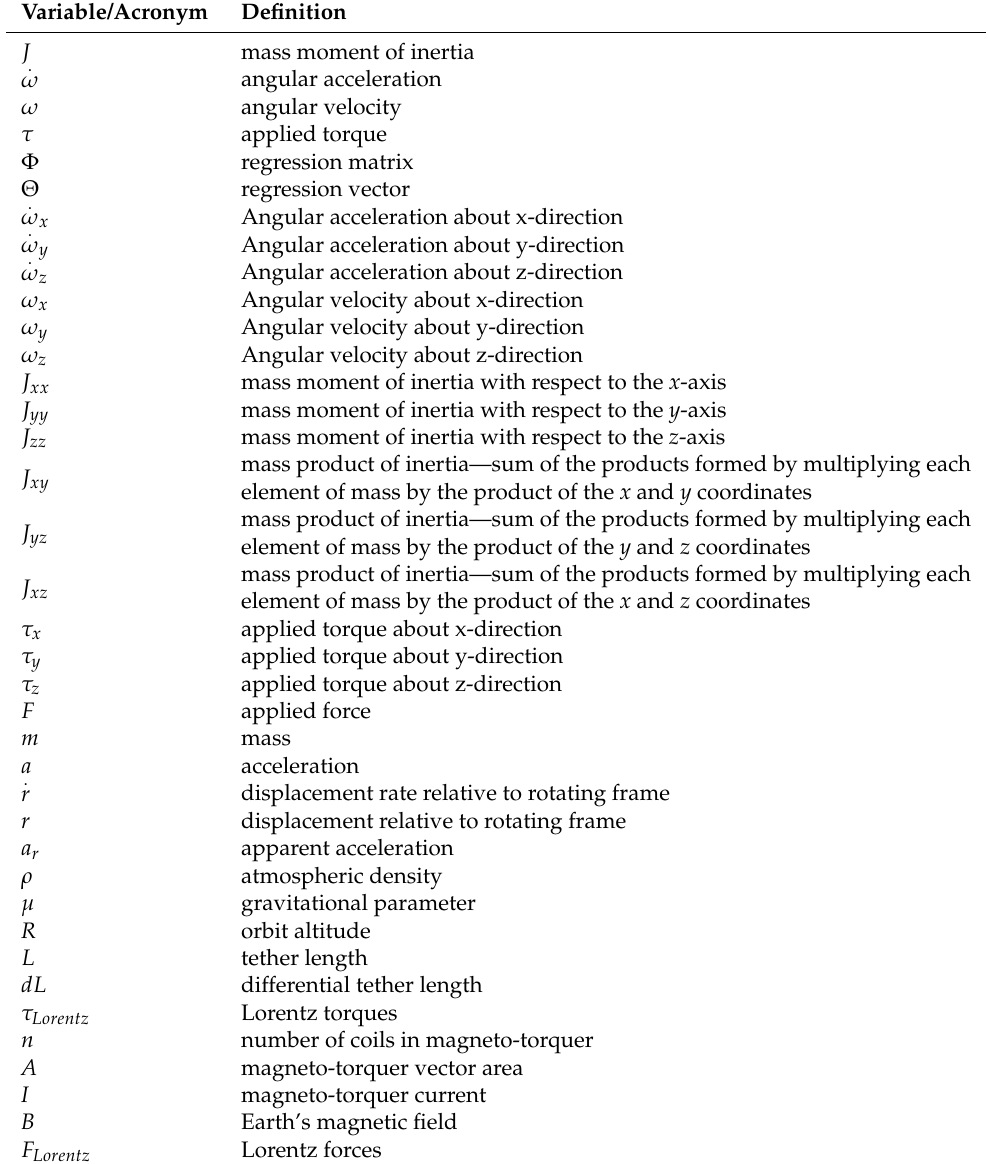
Table A1. Variables and